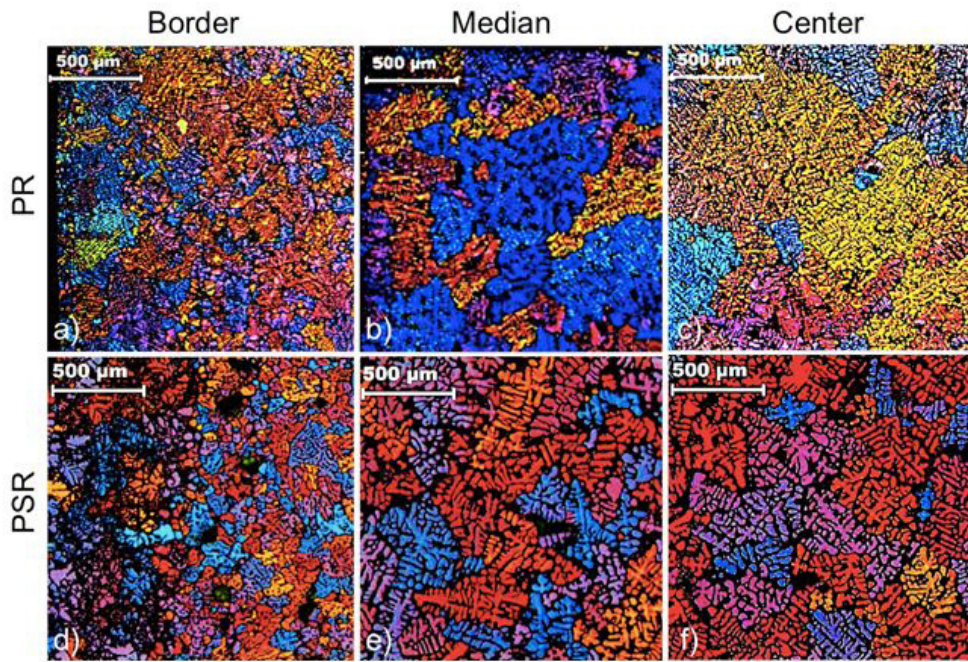
Figure 4. PL microstructure at three locations along a radial cross section of region 1 of an ingot (edge - a, d; middle - b, e; centre - c, f) cast by route 4 without EMS (0 W) (a-f) and with PC (a-c) and PSC (d-f).